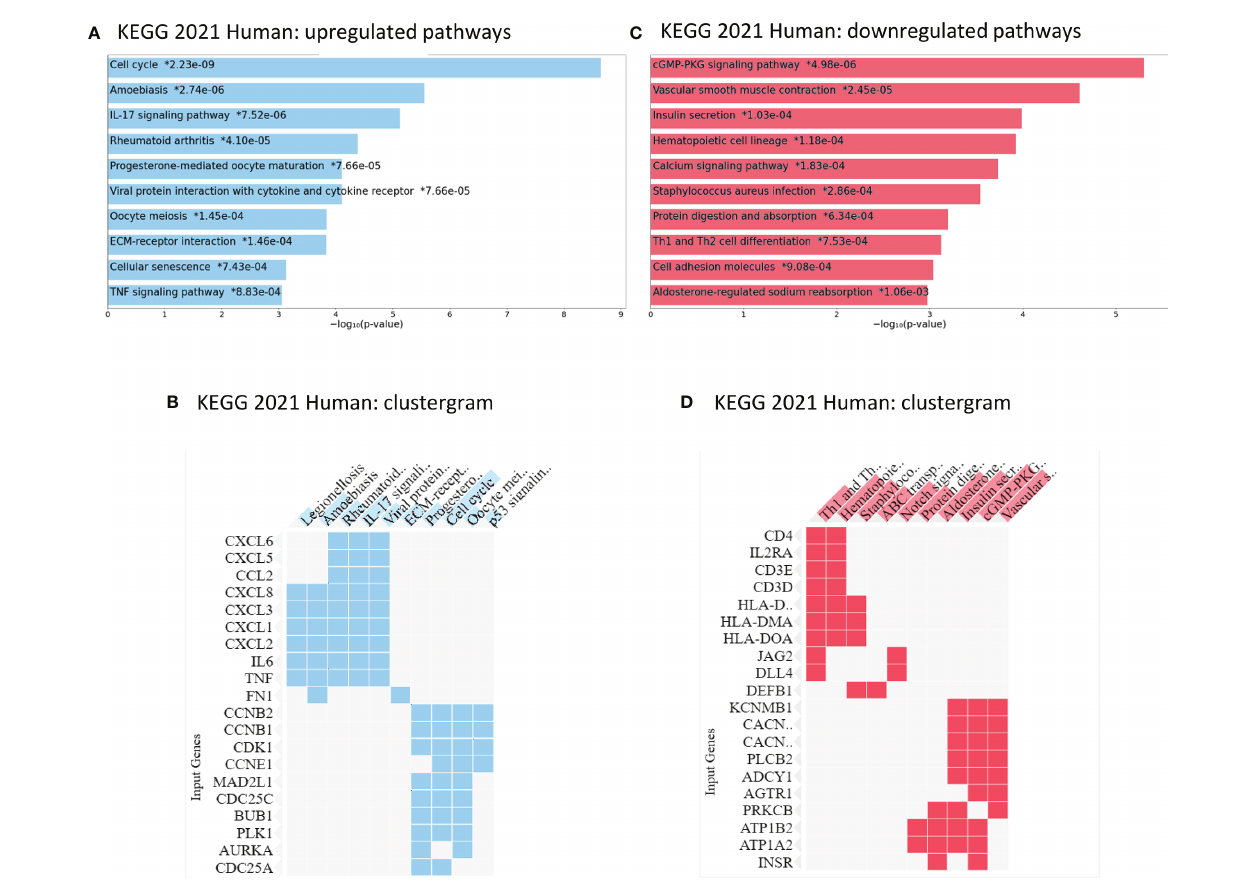
FIGURE 4 | Enrichr analysis of KEGG 2021 Human pathways in ccRCC primary cell cultures: up- and downregulated genes compared to tumor tissue. (A, B) Compared to the tissue of origin, ccRCC primary cell cultures displayed an upregulation in cell cycle regulation, IL-17 pathway regulation, other immune response pathways and genes as well as TNF signaling pathways. (C, D) The primary cell cultures expressed lower mRNA levels of genes involved in calcium signaling, cell adhesion molecules as well as cGMP-PKG signaling pathways. * p- value,